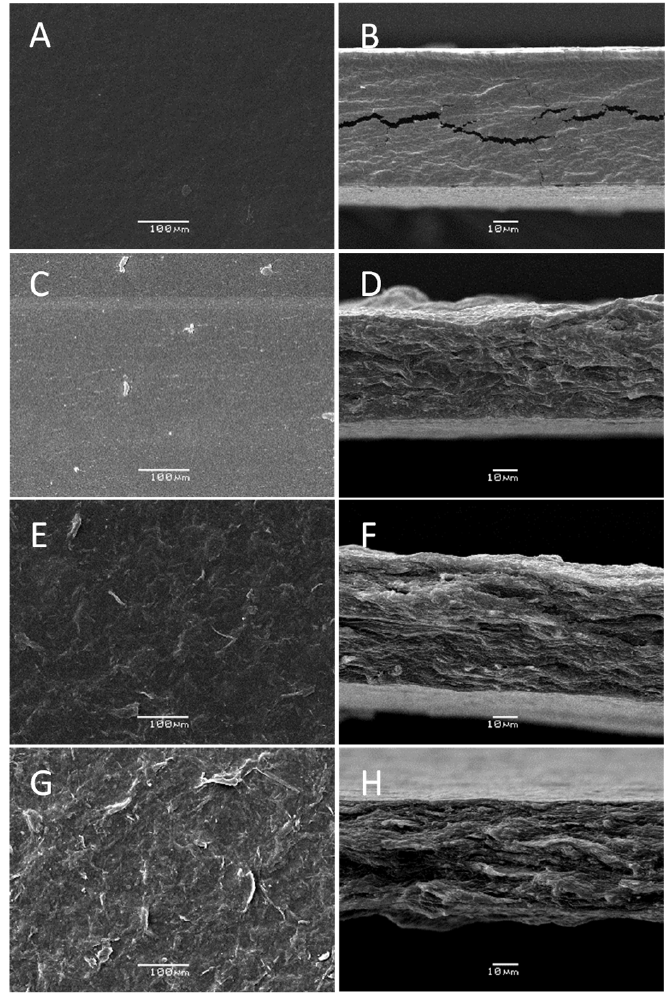
Figure 4. SEM analysis of pectin and pectin biocomposite films with different compositions showing the surface and the cross-section view: P1 ( A , B ), P3 ( C , D ), P4 ( E , F ), and P5 ( G , H ).